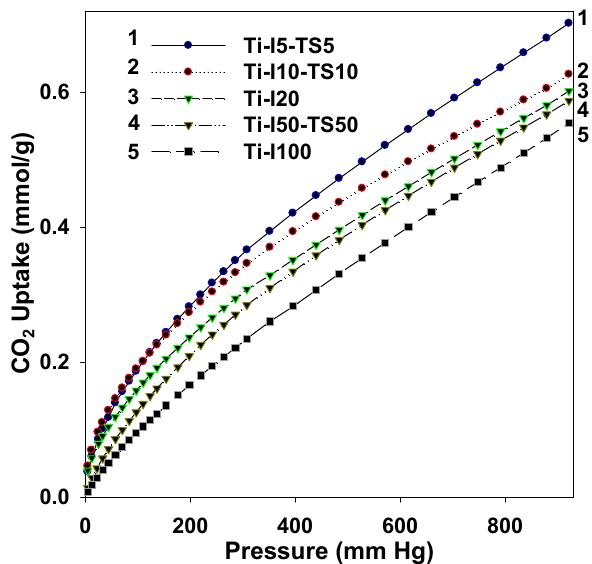
Figure 9. CO 2 sorption isotherms at 25 °C measured on Ti-Ix (x = 20, 100) and Ti-I10-TSx (x = 5, 10, 50).